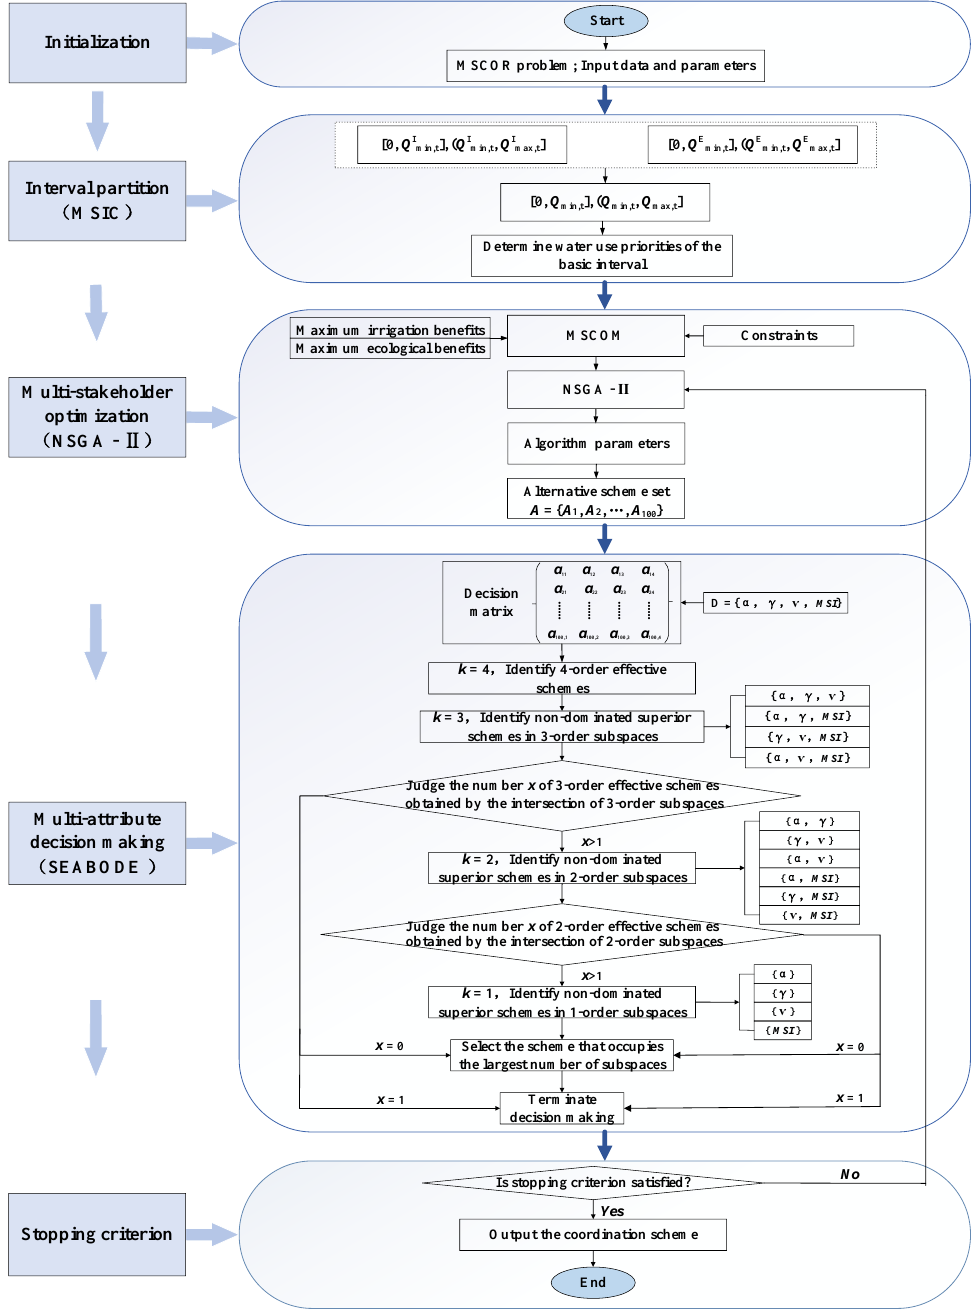
Figure 3. Simplified flow chart of MSIC-NSGA-II-SEABODE algorithm.